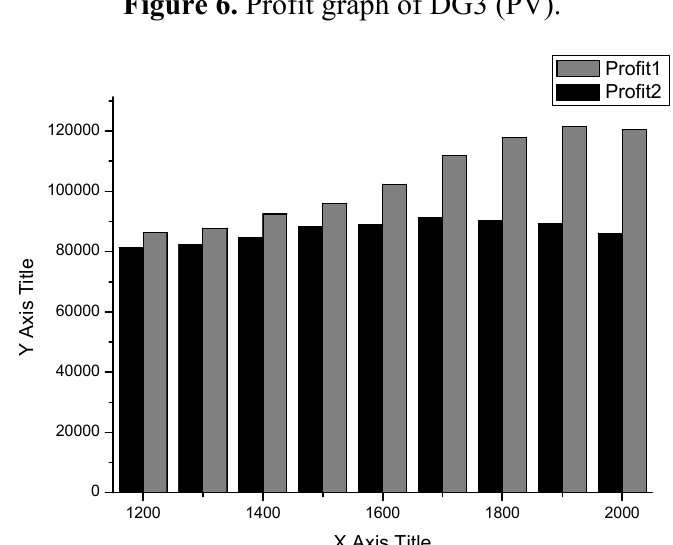
Figure 6. Profit graph of DG3 (PV).